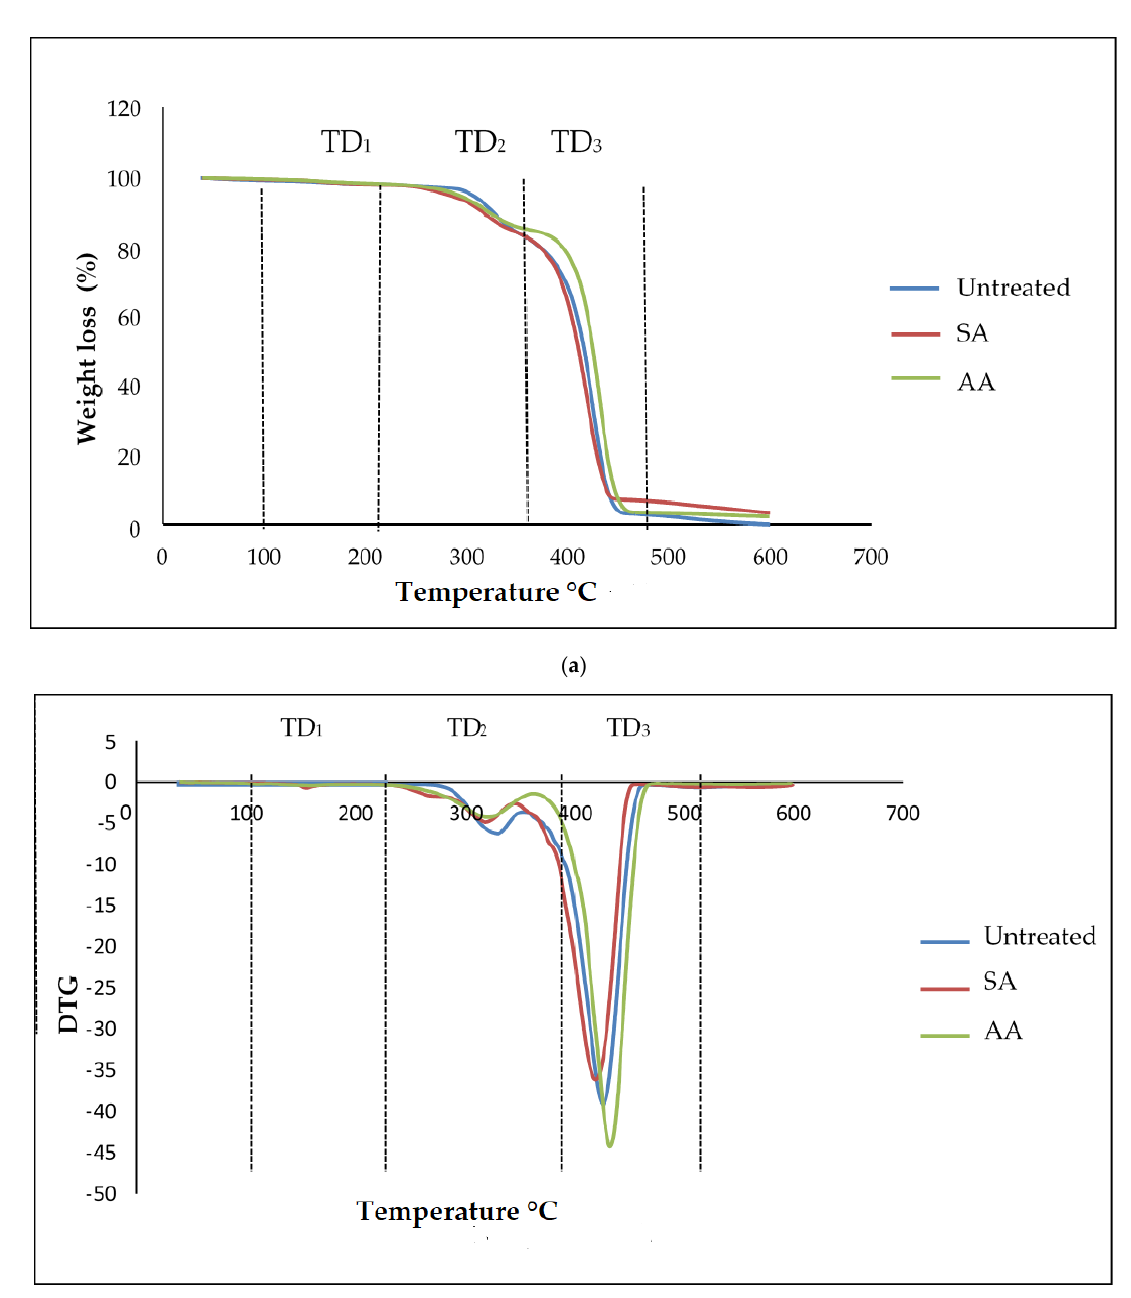
Figure 10. ( a ) TGA curves of PS/TPS blend with a ratio of 80/20 (TPS/PS). ( b ) DTG curves of blend with a ratio of 80/20 (TPS/PS).